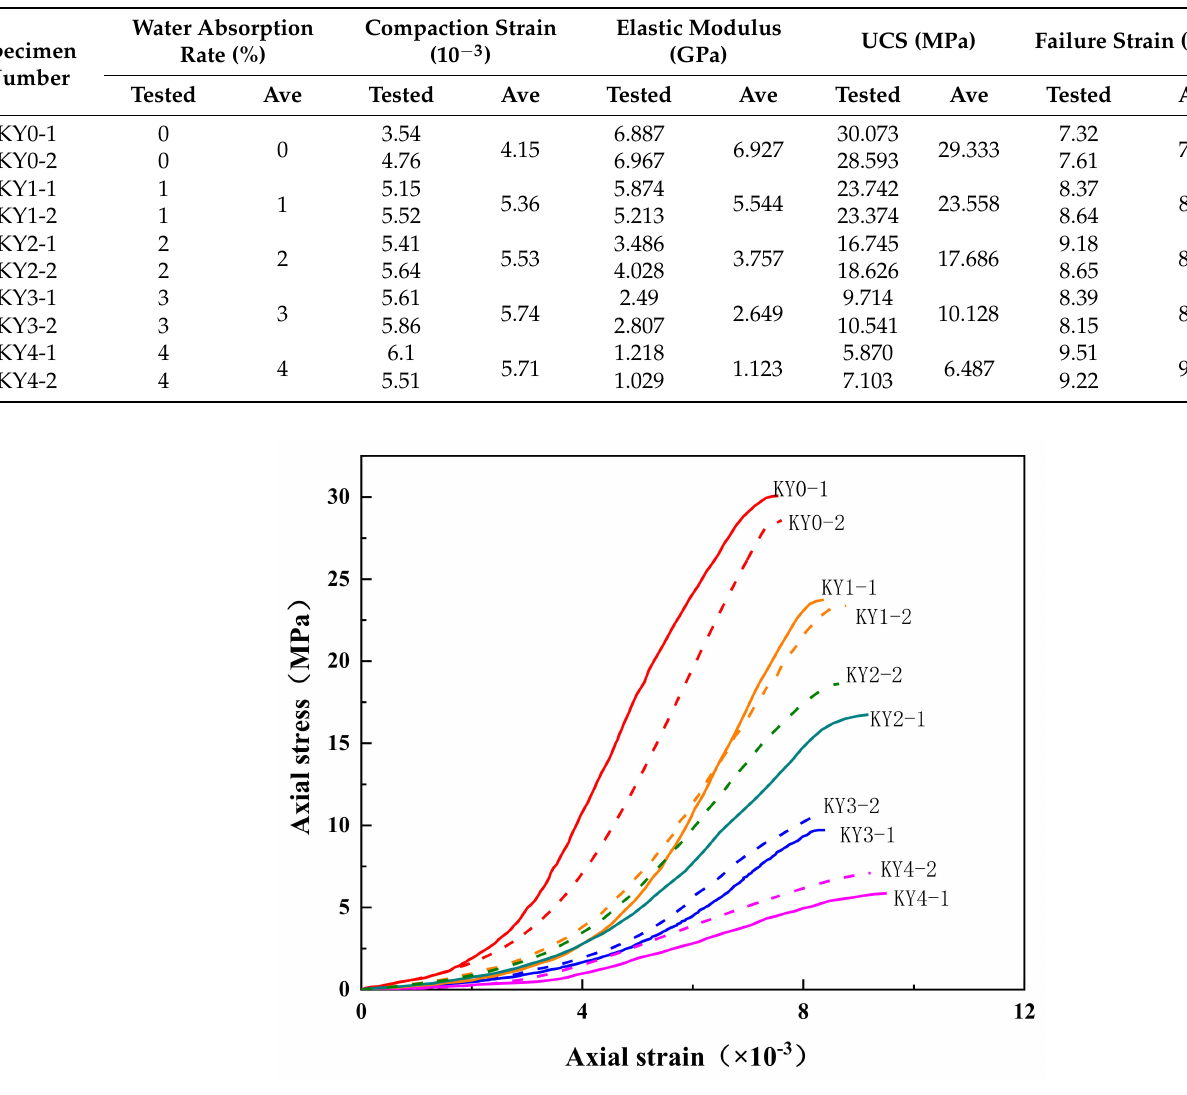
Figure 6. Stress-strain curves for specimens with different moisture absorption rates. note: The figure showed only the rising section of the stress-strain curve (the stage before the peak stress). The reasons for this were twofold. On the one hand, the decreasing section of the curve (the post-peak failure stage) had little influence on the purpose of the test. On the other hand, there were many curves in the graph. If all the descending sections of the curves were added, it would look like the information on the graph was cluttered and inconvenient to